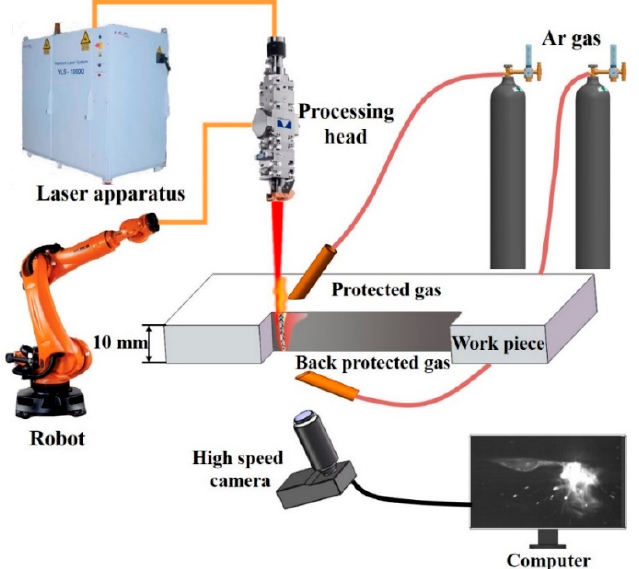
Figure 1. The schematic diagram of experimental set-ups for high power laser welding and observing molten pool behaviors at bottom side.